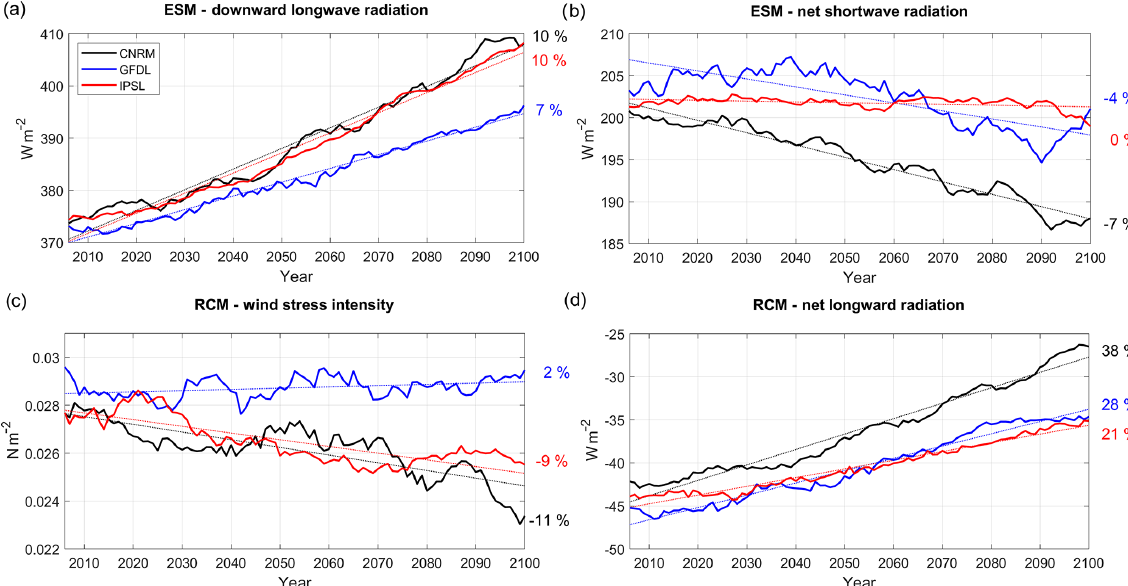
Figure 4. (a) ESM downward longwave radiation (Wm − 2 , positive downward), (b) ESM net shortwave radiation (Wm − 2 , positive down- ward), (c) RCM wind stress intensity (Nm − 2 ), and (d) RCM net longwave radiation (Wm − 2 , positive downward), for the three RCMs (CNRM in black, GFDL in blue, IPSL in red). All fields are averaged in a coastal box (see Fig. 2a), and annual mean time series are filtered using a 10-year moving